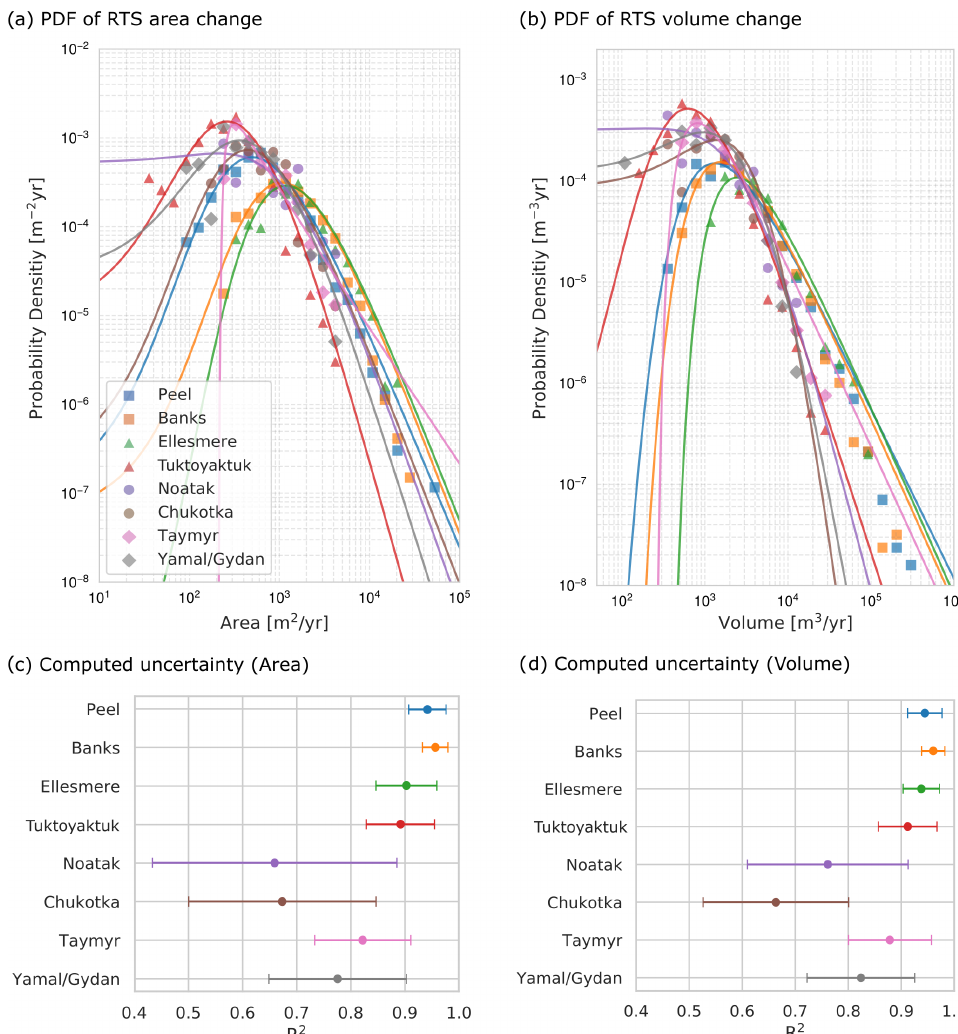
Figure 4. PDF of area and volumetric change rates of mapped RTSs for the set of study sites. Panels (a) and (b) show the PDFs of area and volumetric change rates, respectively, with fitted inverse gamma functions. Panels (c) and (d) show the respective computed R 2